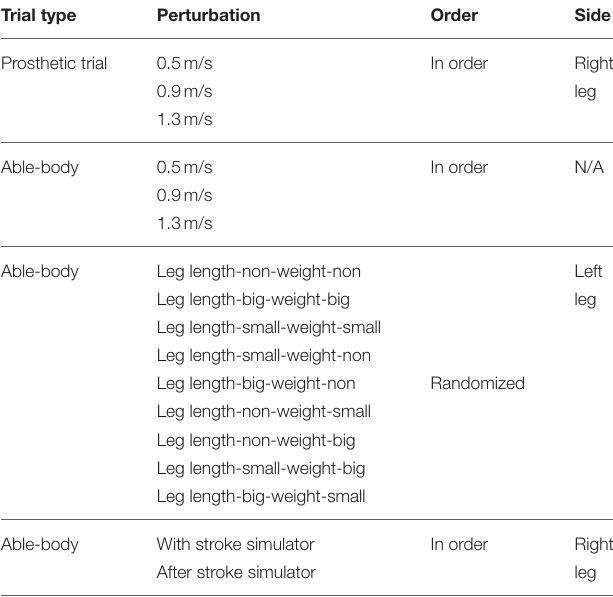
TABLE 2 | Experimental procedure. Trial